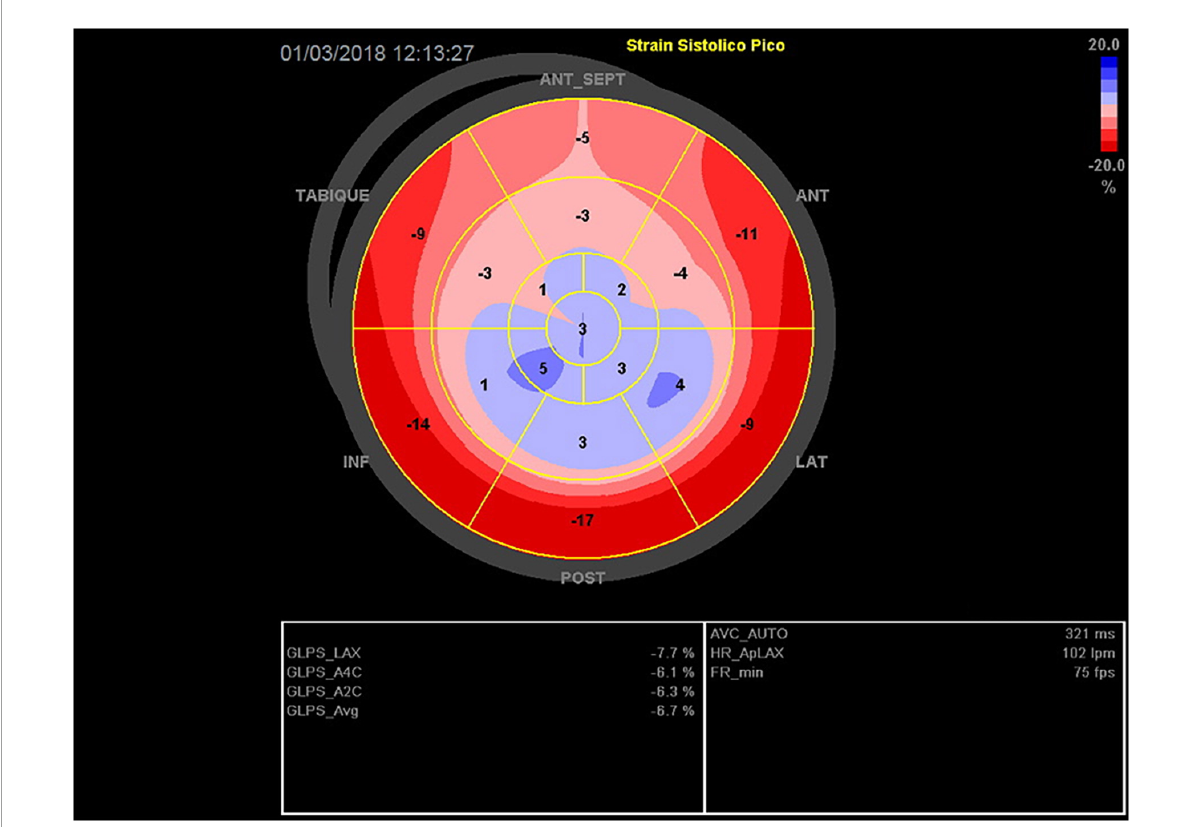
FIGURE4 Global longitudinal strain (Bull’s eye plot) at day 0. Akinesia of all middle and apical segments, with circumferential pattern. Global systolic function is severely compromised (GLS −